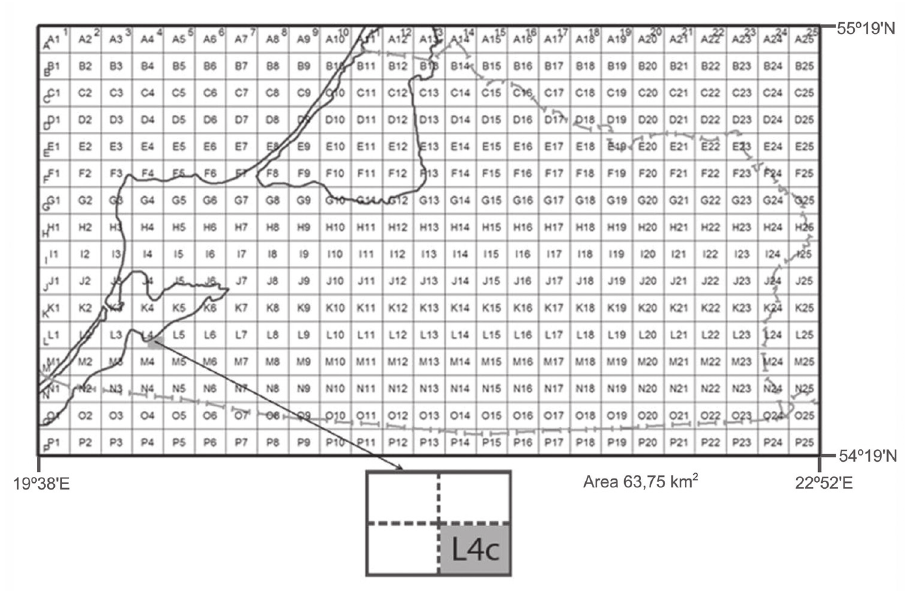
Figure 9. The square grid of the Kaliningrad region with an example of numeration of the “small